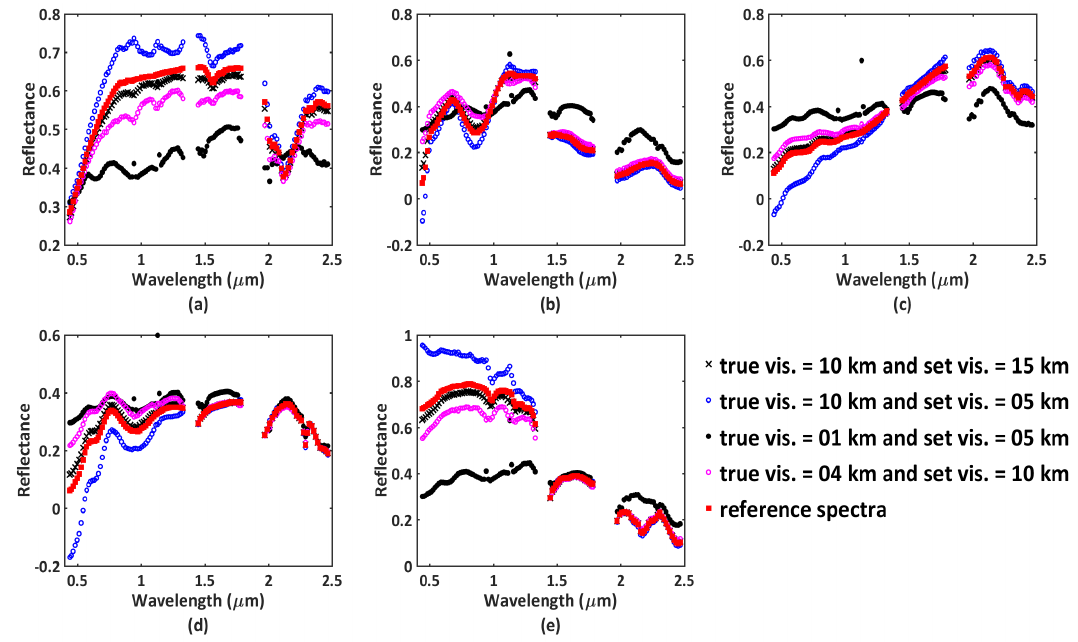
Figure 18. Effects of scattering and variation in visibility on spectral qualities of five endmembers ( a – e ) used to generate the geological dataset with spectrally distinct materials.